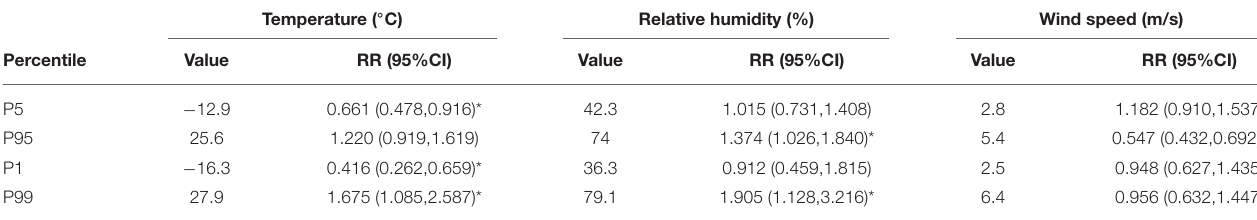
TABLE 3 | Cumulative effects of extreme meteorological variables on PTB at 0–12 lag weeks.